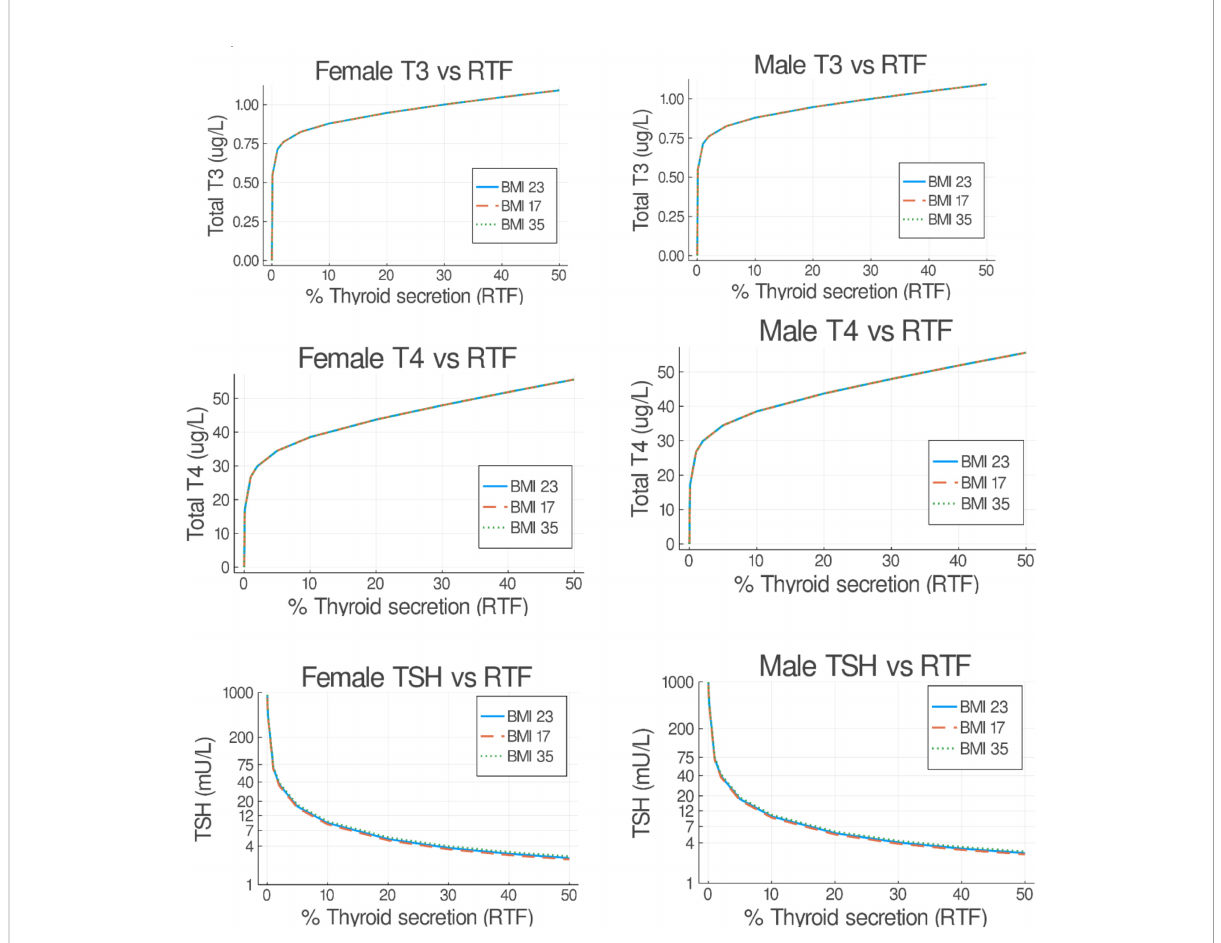
FIGURE 3 Predicted steady state serum T3, T4, and TSH concentrations versus residual thyroid function (RTF) values. Untreated obese, normal and underweight patients were simulated for 50 days. The fi nal steady state T3, T4, and TSH simulation values are shown on the abscissa for each RTF value on the ordinate axis, separated into female (left hand side) and male (right hand side) plots. (From Cruz-Loya et al., Ref